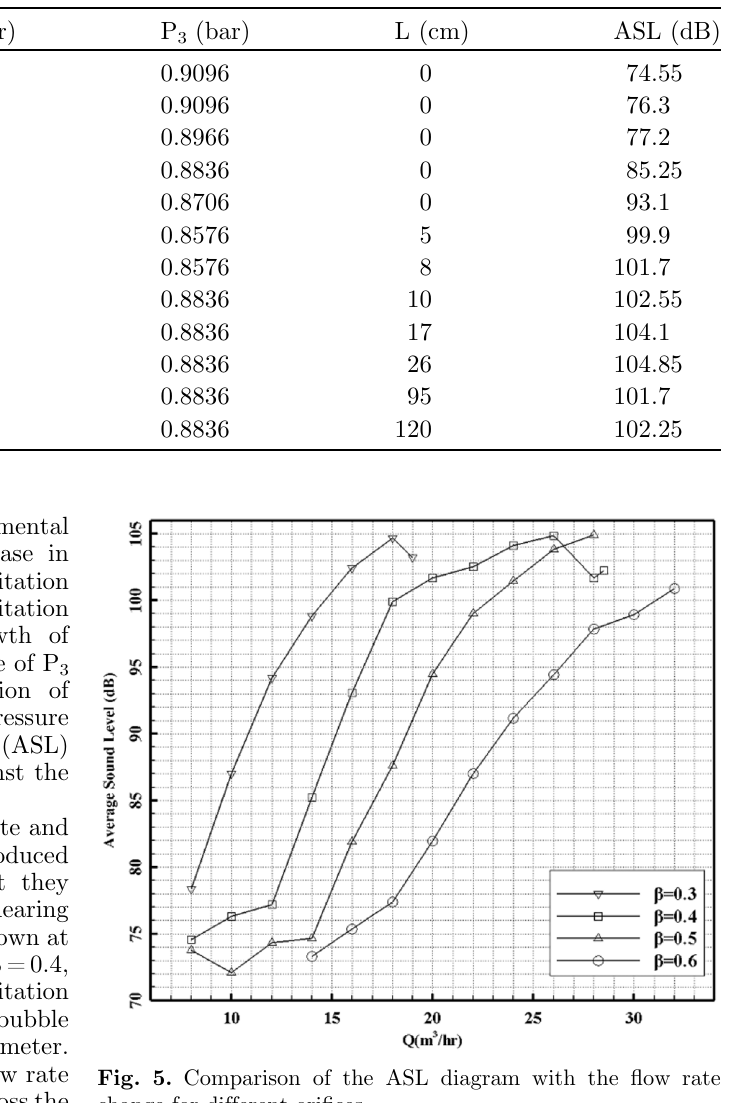
Table 2. The experimental results for the ori fi ce with the 0.4 contraction ratio.